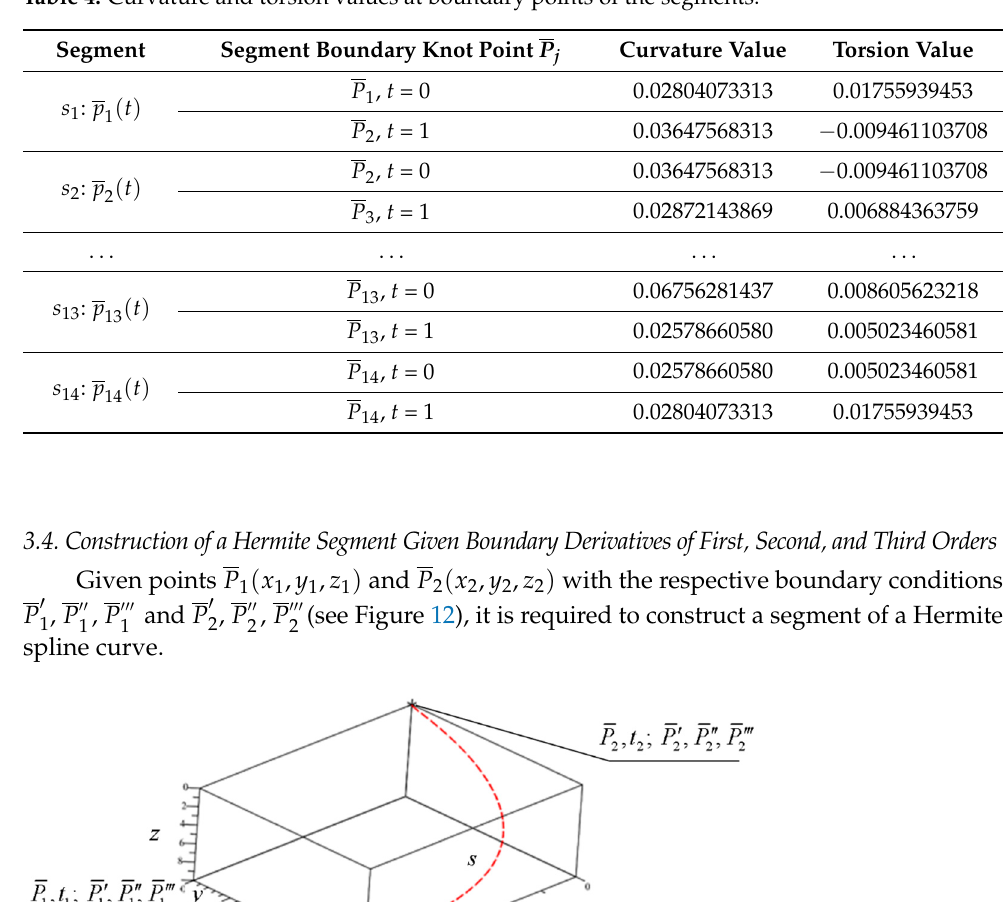
Figure 12. Initial conditions for construction of a seventh-degree Hermite spline curve segment.